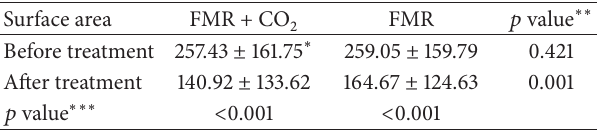
Table 2: Mean surface area before treatment and after treatment in FMR + CO 2 and FMR-treated groups.